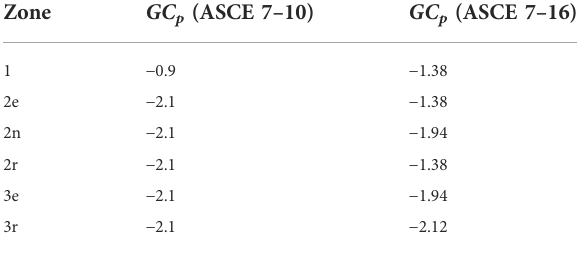
TABLE 2 External pressure coef fi cients in